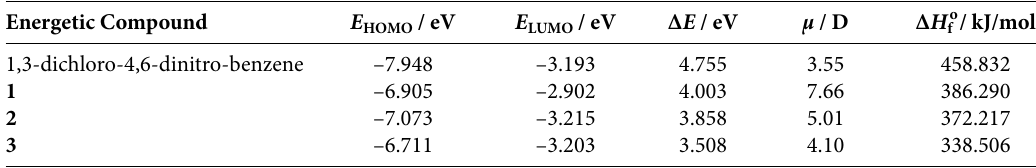
Table 7. The energy levels of the highest energy HOMO and lowest energy LUMO, calculated theoretical dipole moment and formation enthalpy values of the energetic materials prepared. Energetic Compound E HOMO / eV